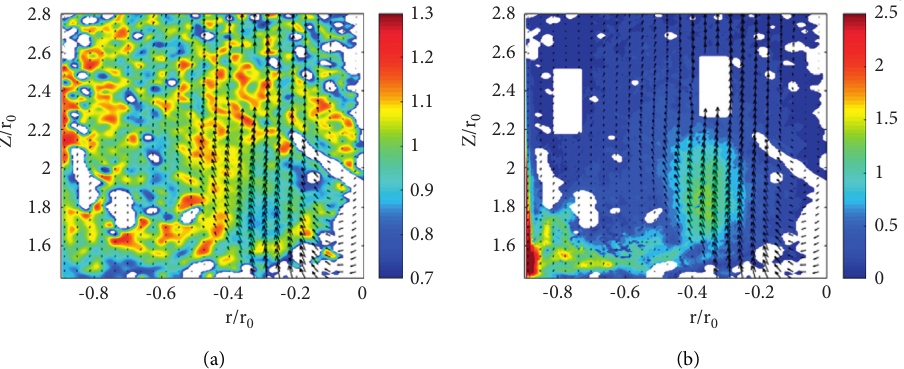
Figure 19: PIM results for equivalence ratio (a) and heat release (b). Scales are equivalence ratio and heat release in Watts/m 3 , respectively.